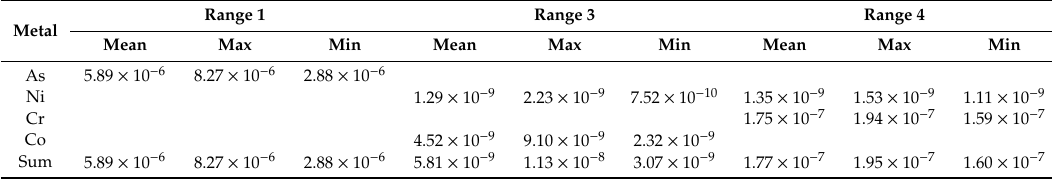
Table 4. Carcinogenic risks (TR) of heavy metals in shooting range soils. Metal